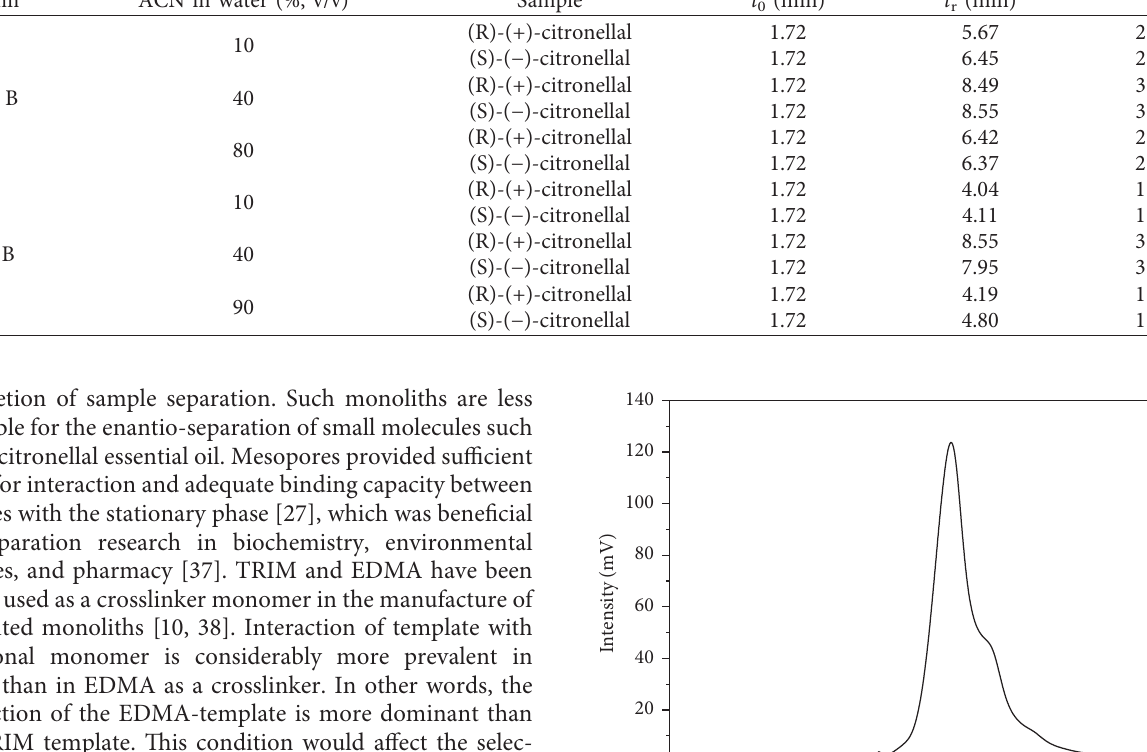
Table 6: Capacity factor (k’) on the MNIP B column using a mobile phase with different ACN compositions using the isocratic elution method. Column ACN in water (%, v/v) Sample